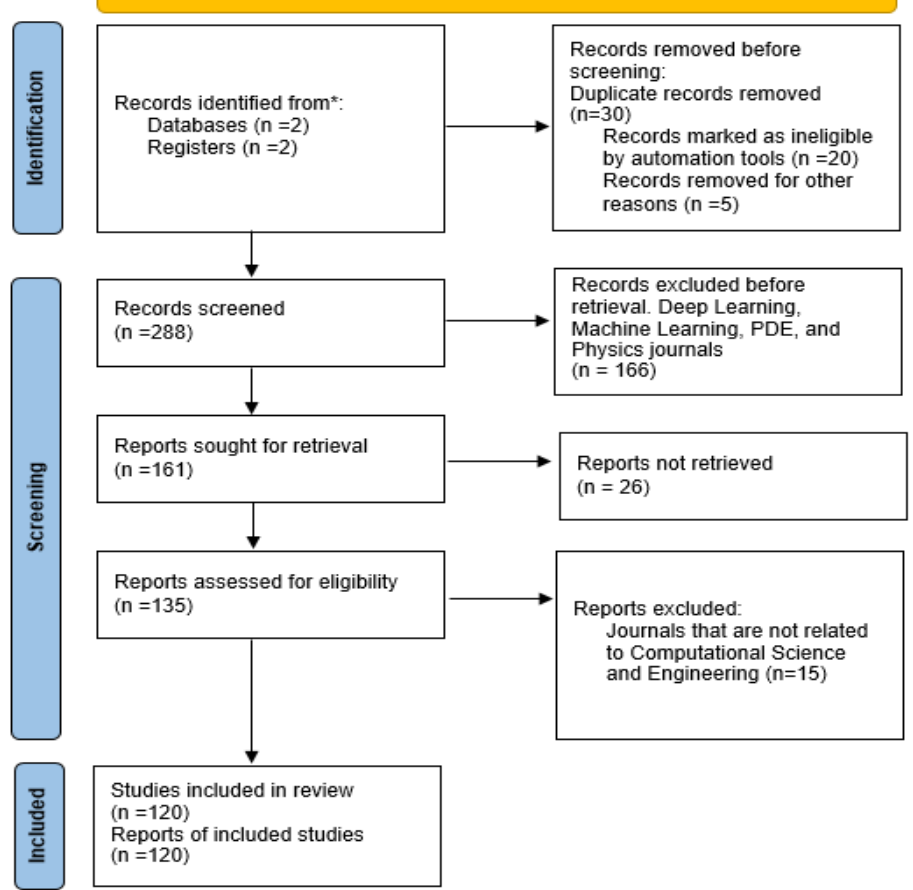
Figure 3. PRISMA flow diagram.